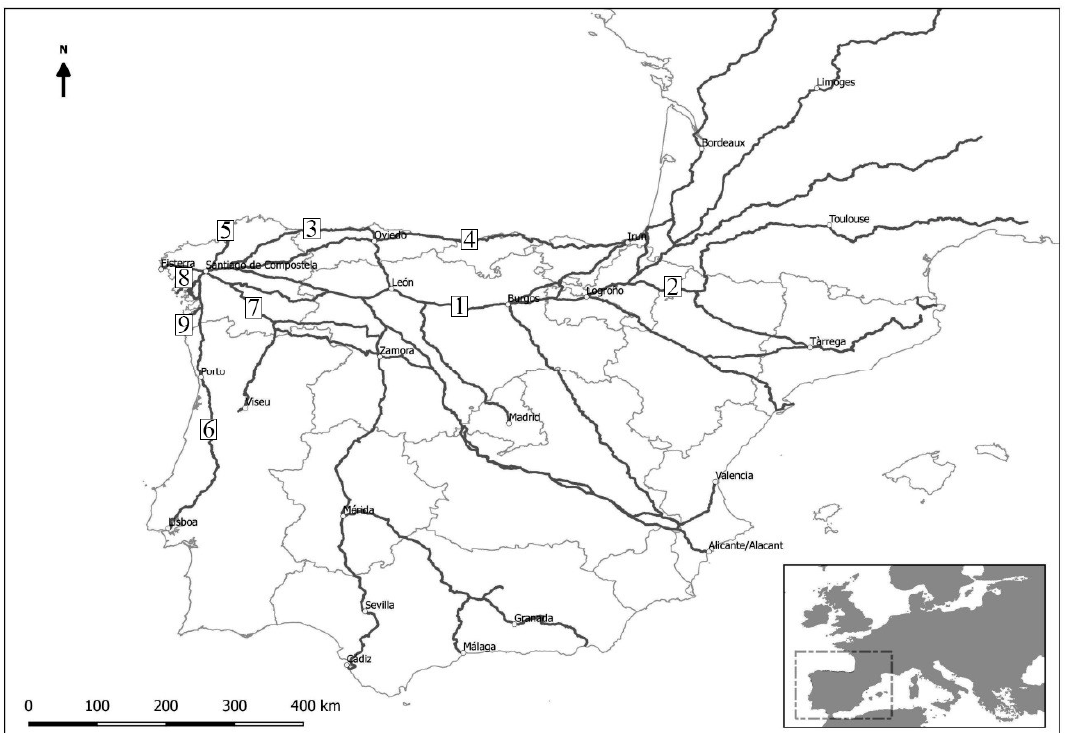
Figure 2. The Ways to Santiago (adaption by Lopez et al. 2017a). There are multiple Ways of St. James, namely, (1) The French Way; (2) The Aragonese Way; (3) The Primitive Way; (4) The Northern Way; (5) The English Way; (6) The Portuguese Way; (7) The Silver Route; (8) The Finisterre/Muxia Way; (9) The Sea Route of Arousa and Ulla